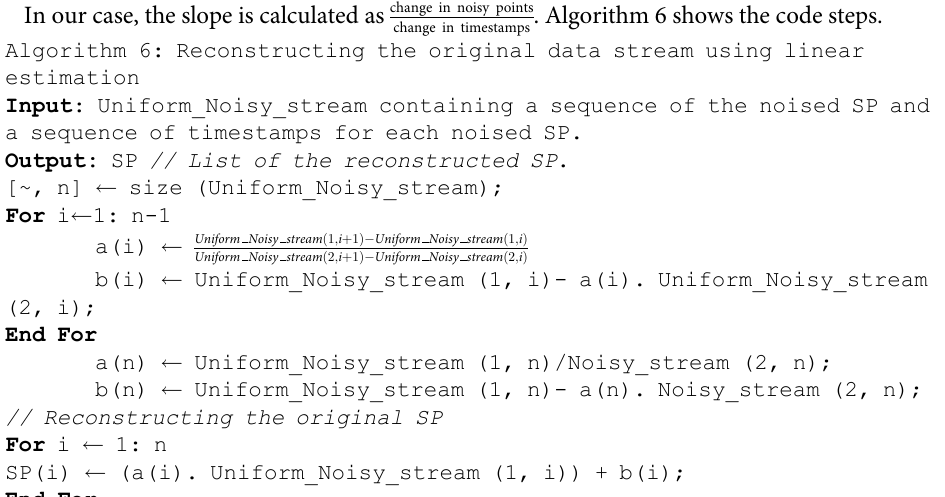
Algorithm 6: Reconstructing the original data stream using linear